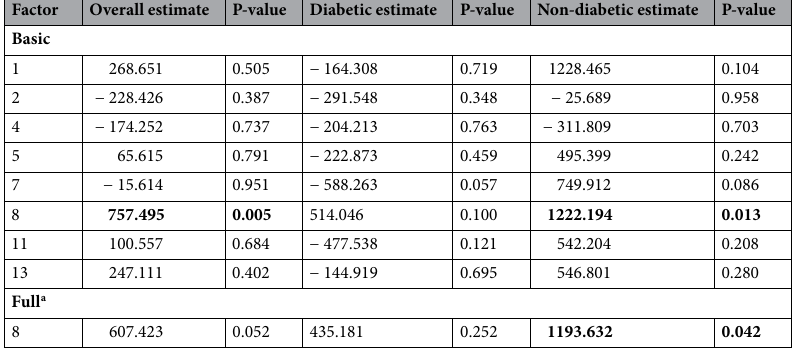
Table 4. Association of baseline factor level with 90-Day change in NT-proBNP. Significant values are in bold. a Model: change in NT-proBNP (D90 – baseline) ~ Baseline factor + baseline